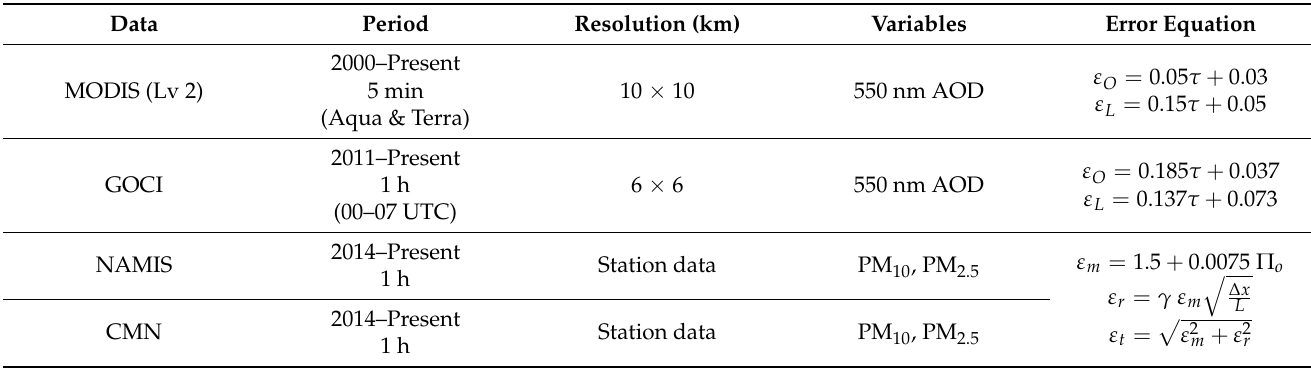
Table 1. Input observation data and the observation error equations. ε O and ε L are the errors over ocean and land, respectively, and τ is the AOD. ε m is the measurement error for ground-based PM observation, ε r is the representative error, ε t is the total error, Π o is the PM concentration, γ = 0.5 is the adjustable parameter, ∆ x is the model grid size, and L = 3 km is the radius of influence of observation according to Elbern et al.